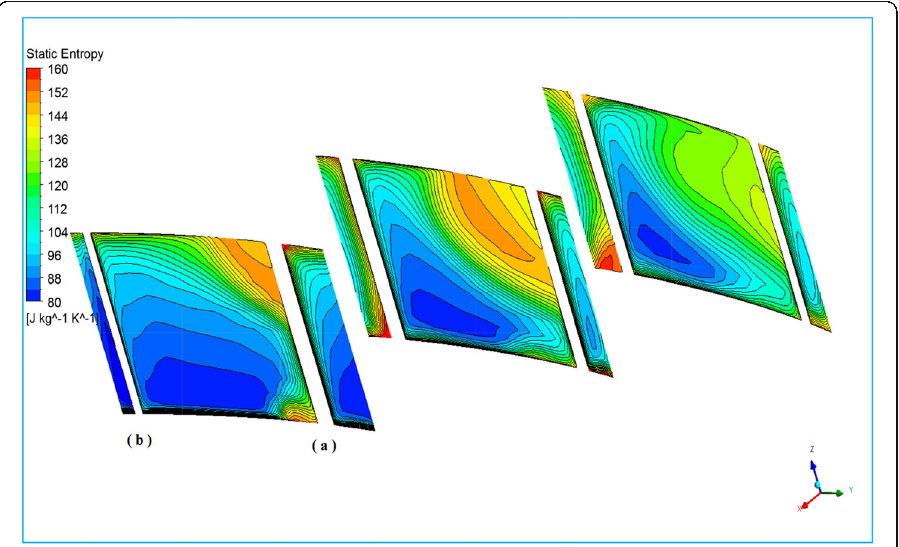
Fig. 17 Entropy distribution at 30, 60, and 90% chord of diffuser-1 for configuration